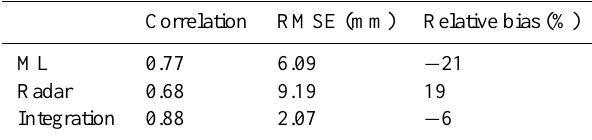
Table 2. Performance analysis event (2) – Dorot site.